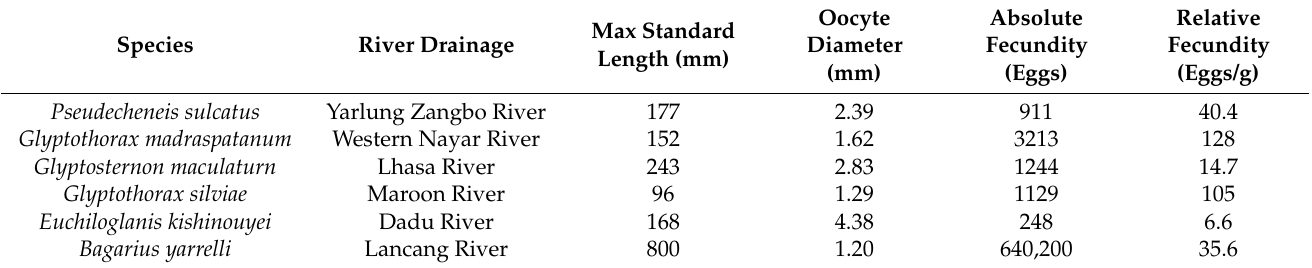
Table 1. Comparison of the reproductive characteristics of several Sisoridae